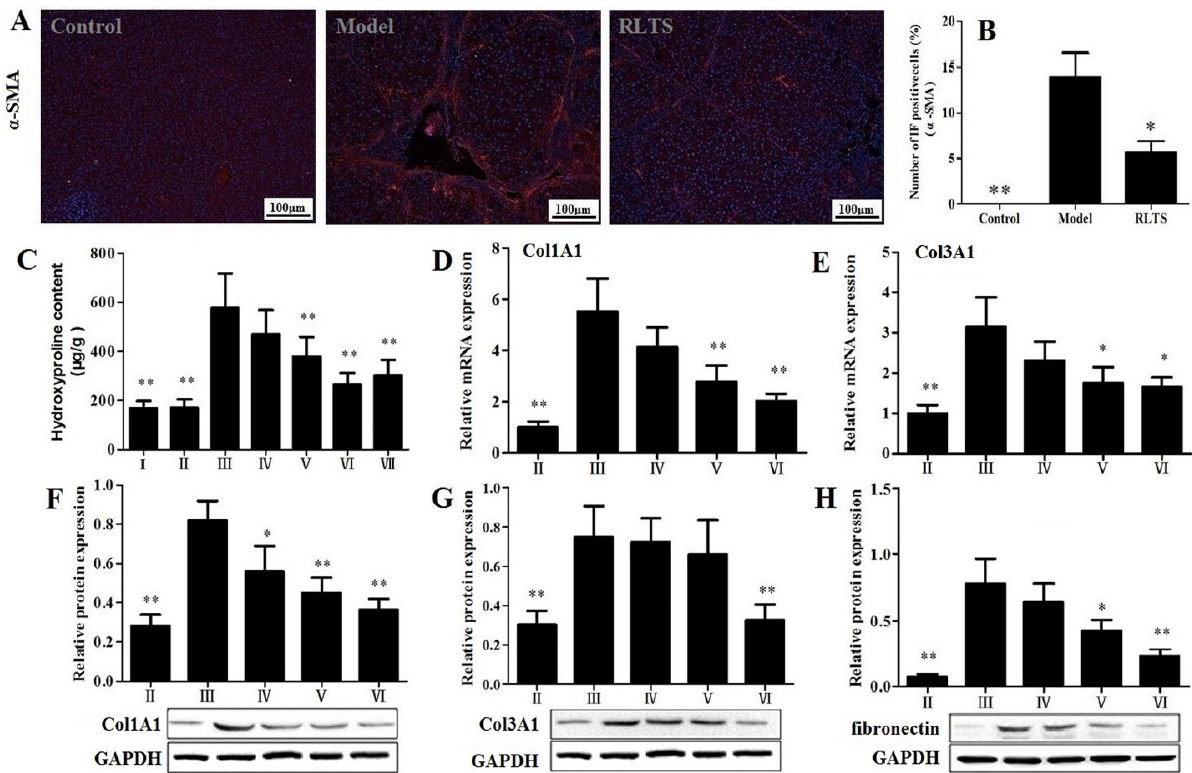
Figure 3. Effect of Rosa laevigata Michx fruit (RLTS) (210 mg/kg) on the expression of α-SMA based on immunofluorescence assay (magnification, 100×) ( A ); Statistical